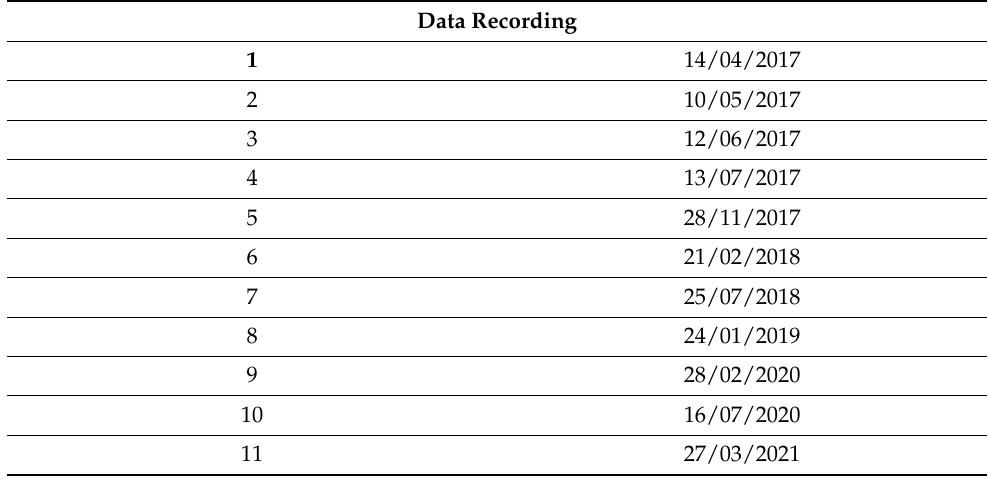
Figure 2. Anthropometric and BIA recording data: ( A ) weight; ( B ) PhA; ( C ) BCM; ( D ) LMI. Table 2. Date of BIA measurement.